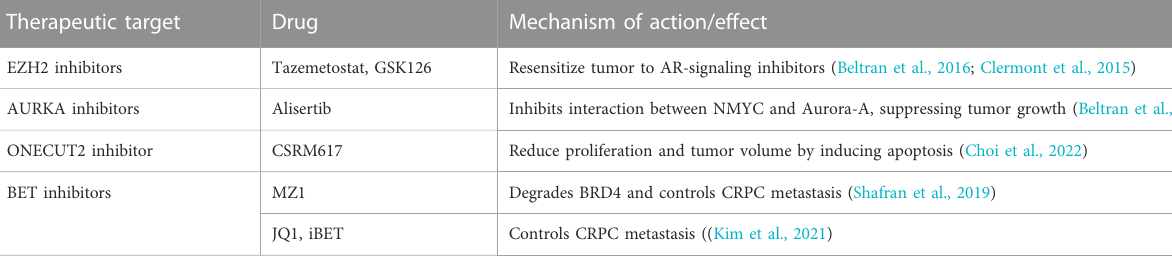
TABLE 1 Preclinical evaluation of therapeutic strategies targeting TFs and chromatin modi fi ers in NEPC. Therapeutic target